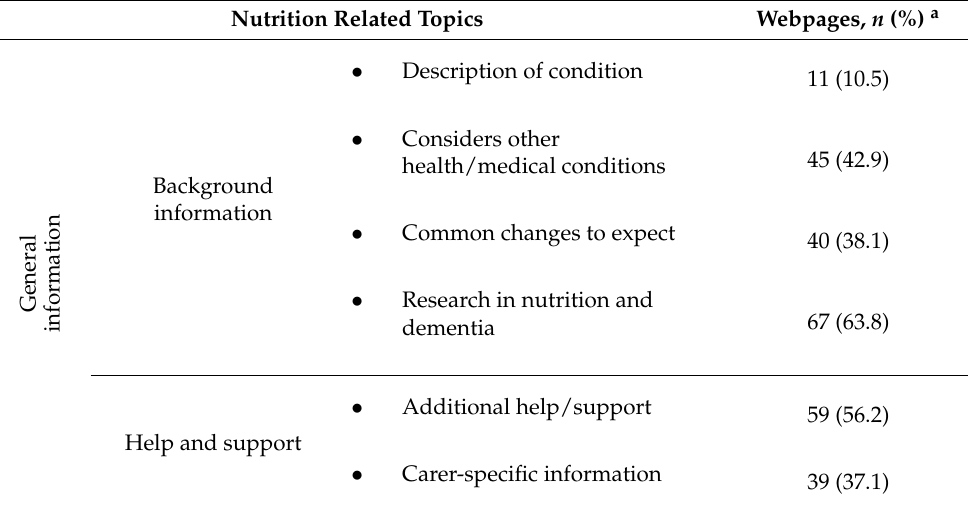
Table 2. Nutrition-related topics of webpages exploring the prevention and/or treatment of dementia (N =